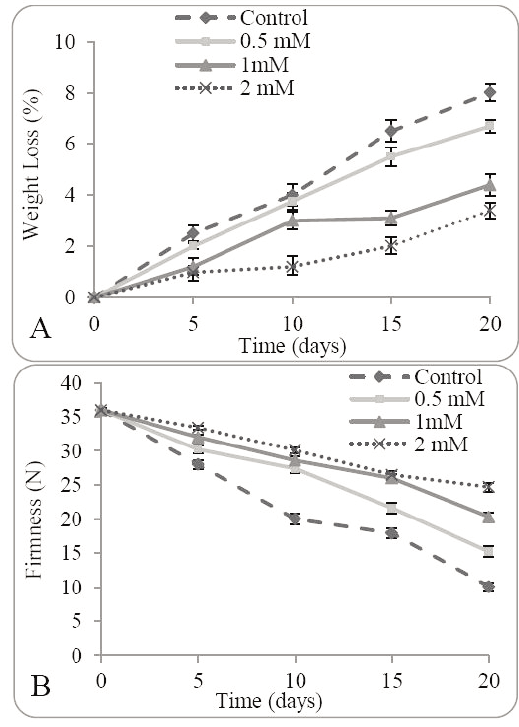
Fig. 1 - The effect of putrescine at different concentrations (0.5, 1 and 2 mM) on weight loss (A) and firmness (B) of Musa acuminata L. during